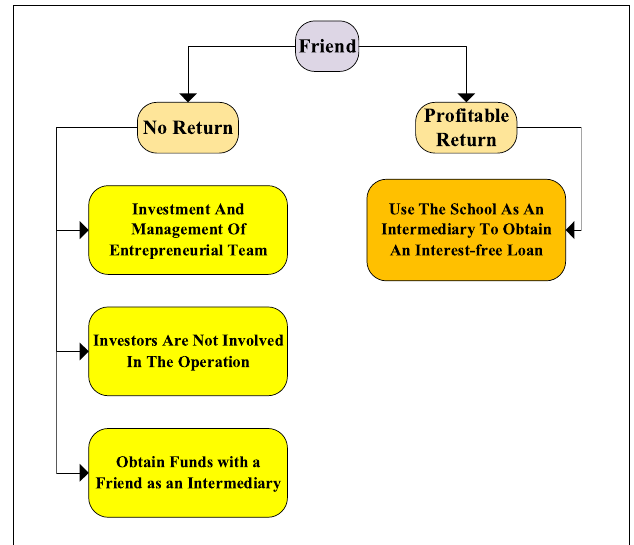
FIGURE 4 | Sources of funds for